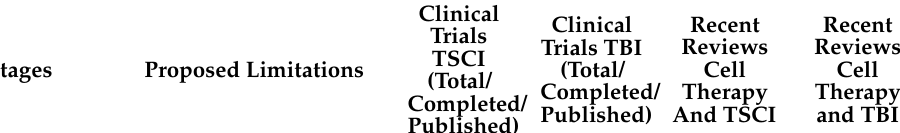
Table 1. Overview of different cell types used in TSCI and TBI treatment studies and recent reviews regarding those cell therapy strategies in TSCI and TBI. Different cell types display specific favourable and disadvantageous characteristics for therapy in TBI and TSCI, as summarized in the second and third column. For TSCI, numerous registered clinical trials were identified, of which nearly 1 were completed and 1/3 have published results. For TBI there were fewer trials identified, 2 with only three published results. While some trials have led to more than one paper publishing results, other papers include results from more than one registered trial. Compared to some published reviews also including non-registered trials [326], our numbers of trials and publications are clearly lower. Under registration of clinical trials may be a relevant aspect, beyond this issue [327]. Nevertheless, considerable data on MSC therapy in TSCI is available, displaying safety [275], while optimal application and demonstration of relevant treatment effects warrant further